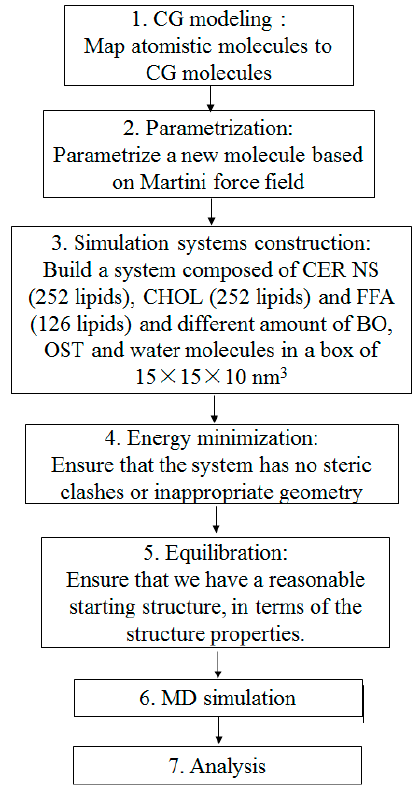
Figure 11. The flow chat of the coarse-grained molecular dynamic (CG-MD) simulation process.